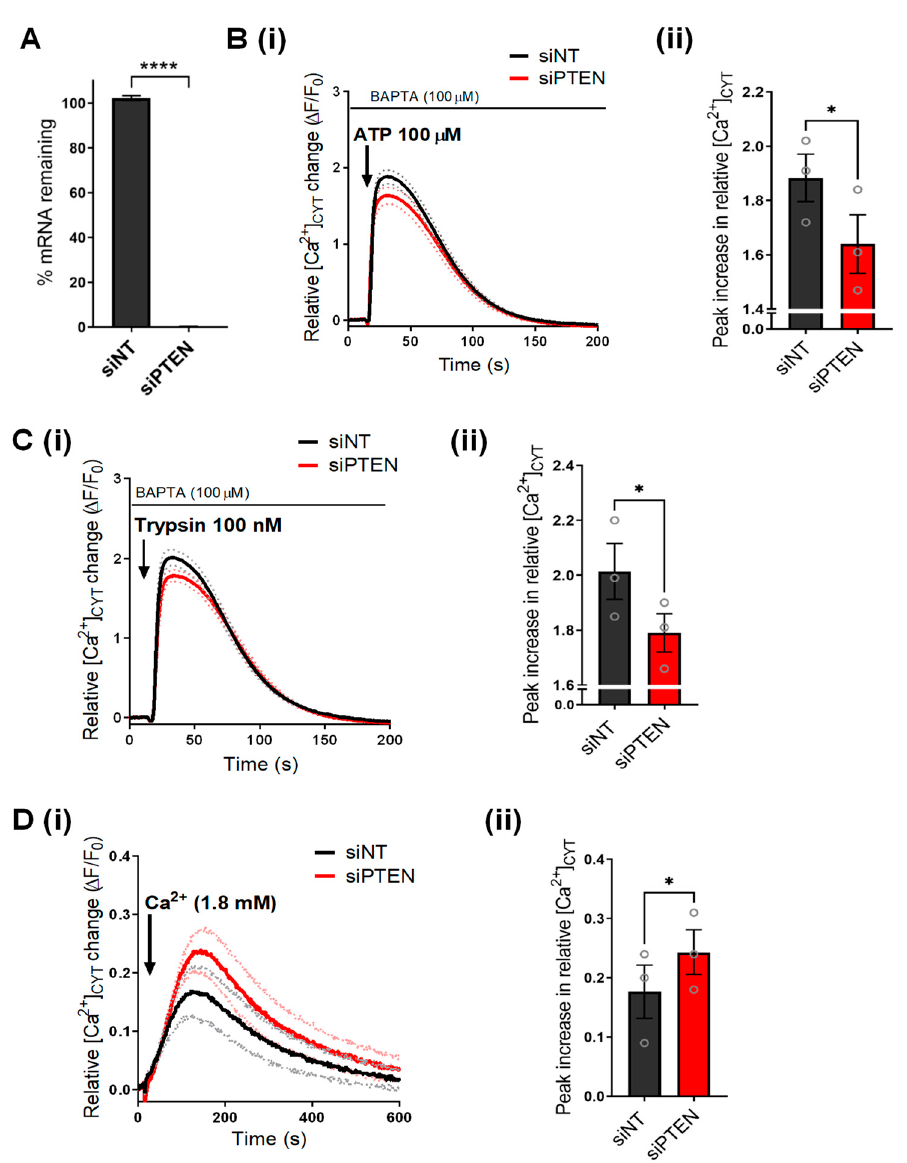
Figure 1. PTEN silencing remodels Ca 2+ signaling in GCaMP6m-MDA-MB-231 cells. ( A ) Bar graph shows percent mRNA remaining in PTEN silenced (siPTEN) cells compared to NT control (siNT). Traces (i) show the mean relative [Ca 2+ ] CYT increases in GCaMP6m-MDA-MB-231 cells as a result of ( B ) ATP 100 µ M, ( C ) trypsin 100 nM or ( D ) CaCl 2 (1.8 mM) addition to siNT or siPTEN-treated GCaMP6m-MDA-MB-231 cells. Dotted lines on the traces represent the S.E.M of the mean F/F 0 of three biological replicates. Bar graphs compare the (ii) maximal or peak relative increase in [Ca 2+ ] CYT between siNT and siPTEN transfected cells. Data represent the mean ± S.E.M. (n = 3) and were analyzed using a paired t -test. **** < p < 0.0001, * p < 0.05 .